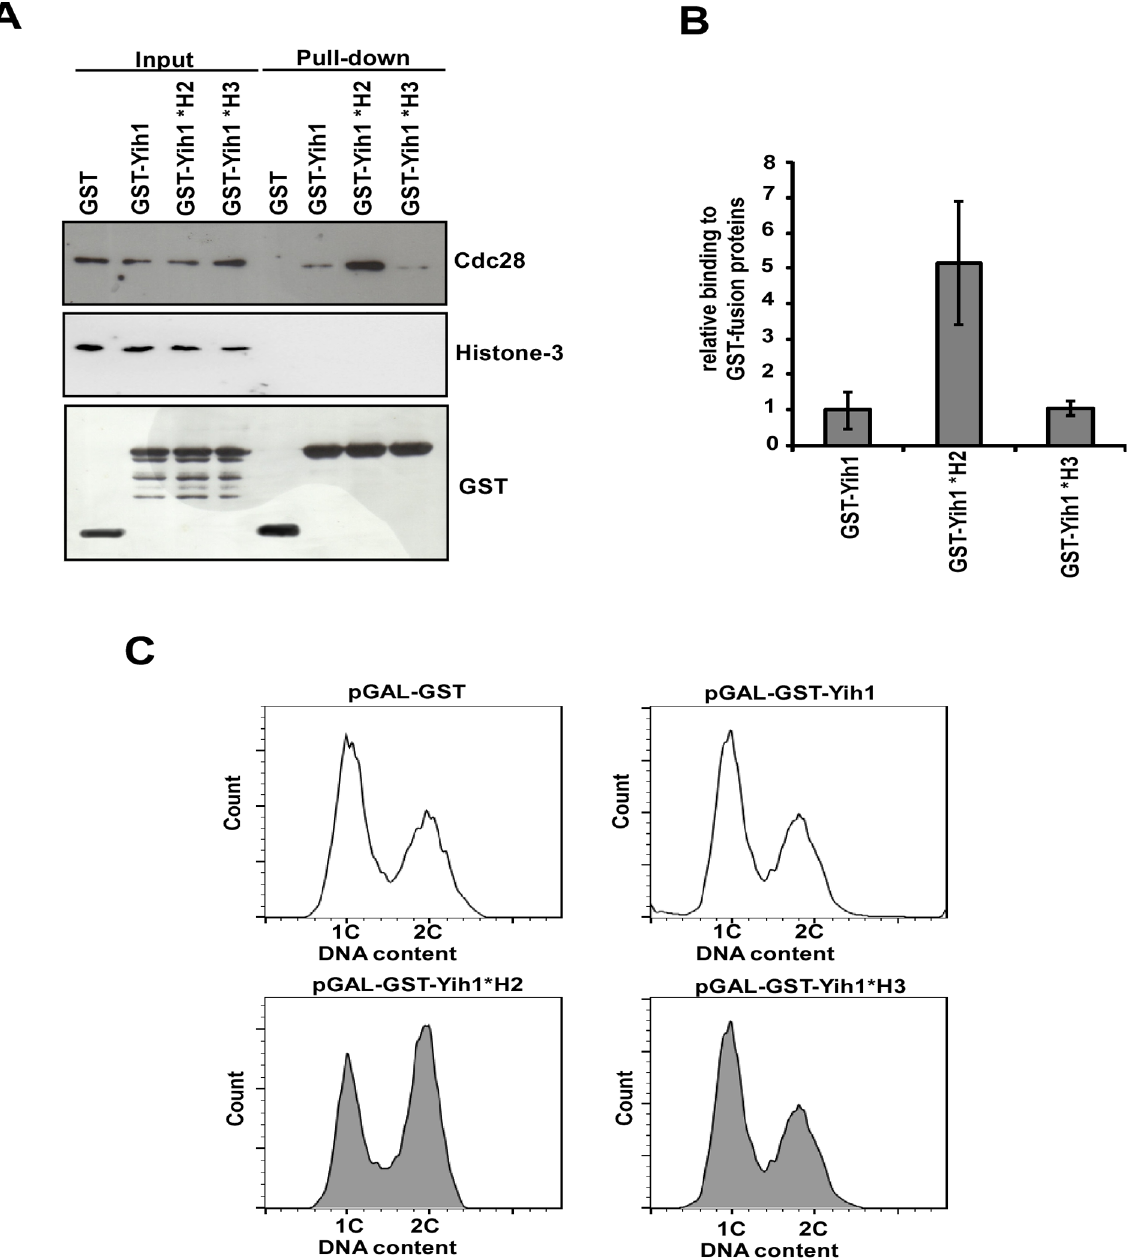
Fig 10. Effect of Yih1 RWD domain amino acid substitutions on Cdc28 binding. (A) In vivo GST-pull-down assays were performed on yih1 Δ strains (MSY-Y2) expressing the GST-Yih1 fusion proteins as indicated, or GST alone, from a galactose inducible promoter. * H2 depicts E87A and D90A substitutions and * H3 depicts D102A E106A substitutions. Cells were grown to log-phase and harvested. Equal amounts of WCEs (2 mg) were subjected to glutathione-mediated GST pull-down assays. The precipitates (100% of the bound proteins – right) and the input (1/100 th of the input – left) were assessed by immunoblot to detect the indicated proteins. One representative blot from three independent experiments is shown. (B) Amount of endogenous Cdc28 bound to the GST-Yih1 fusion proteins was determined from (A) by dividing the signal intensity of Cdc28 by the precipitated amount of the respective GST-Yih1 fusion proteins. Data represent means and S.E. of three independent experiments. (C) Representative flow cytometry histograms showing the DNA content of wild type cells (MSY-WT2) expressing GST alone, GST-Yih1 (unfilled histograms), GST-Yih1 * H2 or GST-Yih1 * H3 (gray filled histograms) from a galactose inducible promoter. The distribution of cells in G1 (1C), S and G2/M (2C) is